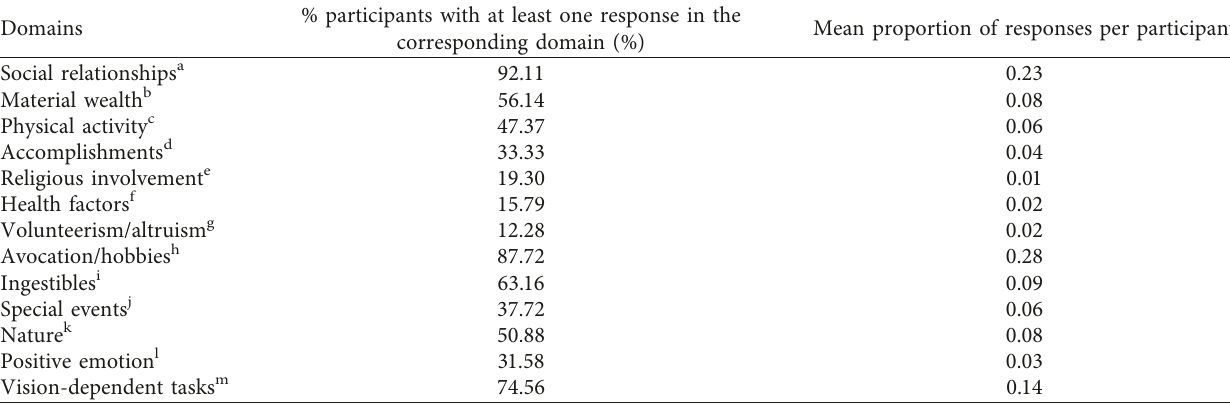
Table 3: Qualitative content analysis of responses to the task “name things that make people happy” ( n � 114 participants, n � 1731 responses).